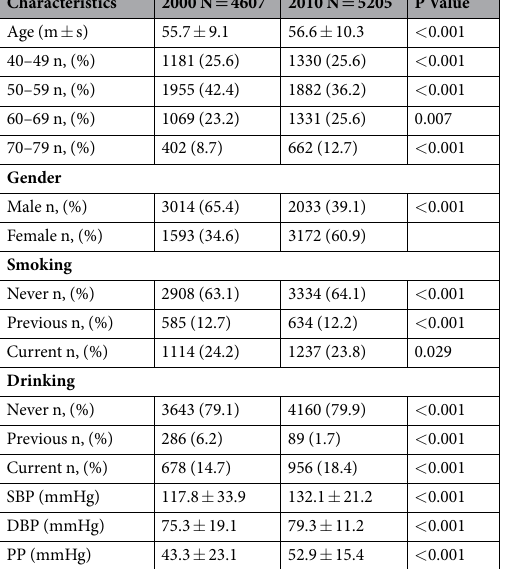
Table 1. Characteristics of participants in 2000 and 2010. SBP, systolic blood pressure; DBP, diastolic blood pressure; PP, Pulse pressure. Data are presented as mean ± standard deviation (m ± s) for continuous variables and as frequencies (percentages) for categorical variables. Statistical comparisons are from Pearson chi square tests for categorical variables and one way ANOVA for continuous variables.